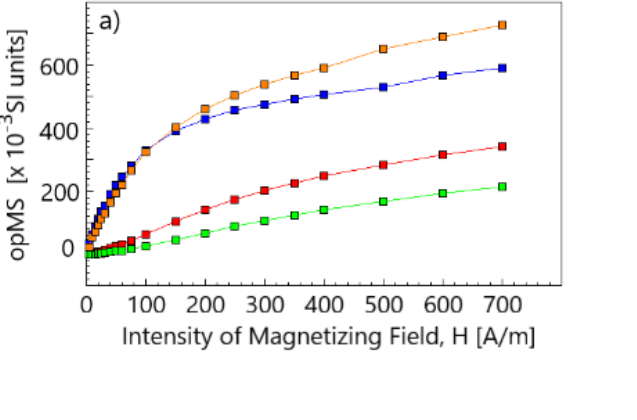
Figure 12. Variation of opMS with magnetizing field ( a ), variation of ipMS with field ( b ), variation of ipMS with temperature ( c ) (in red—heating curve, in blue—cooling curve) in the locality of Hut ě .